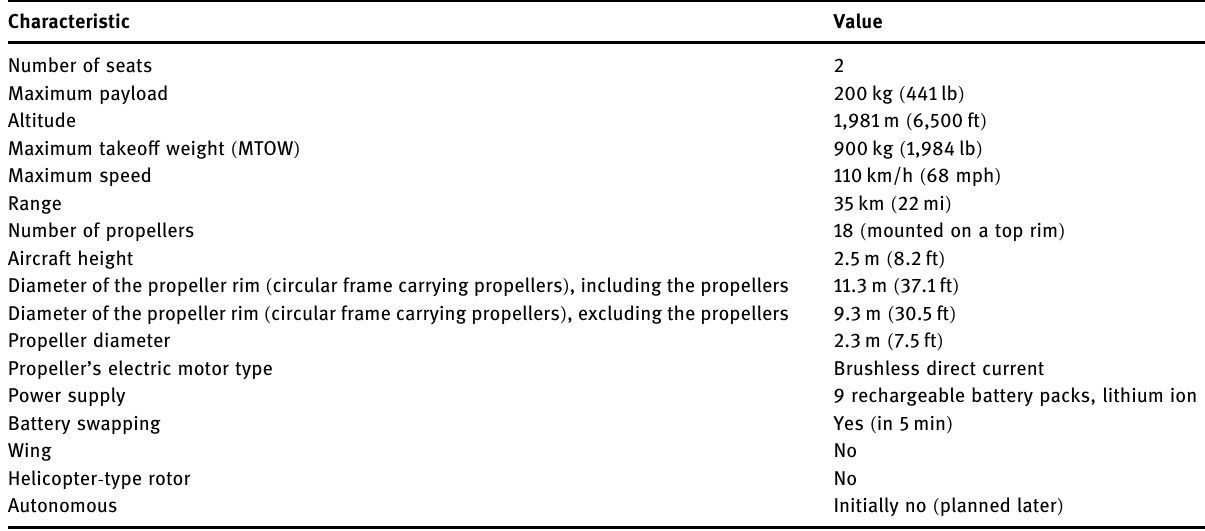
Table 2: Some characteristics of VoloCity UAM aircraft Characteristic Value Number of